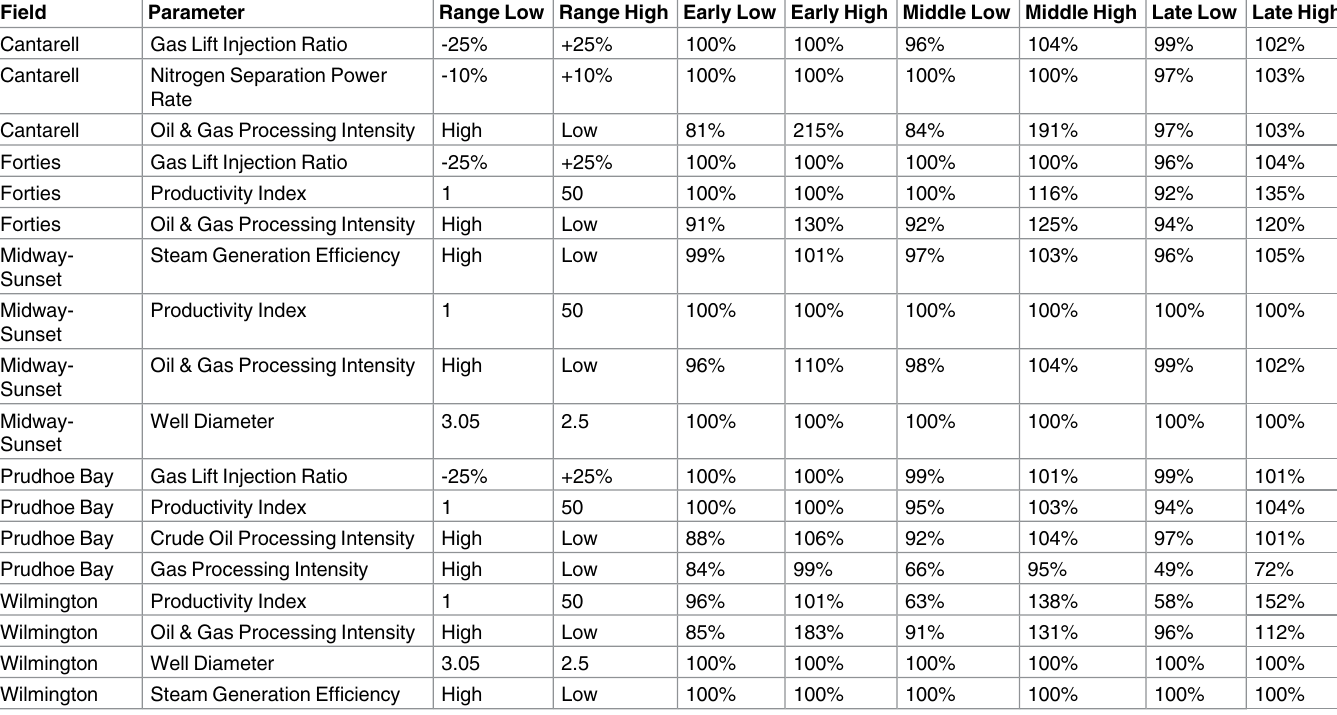
Table 7. Sensitivity analysis results for NER total at each field and time